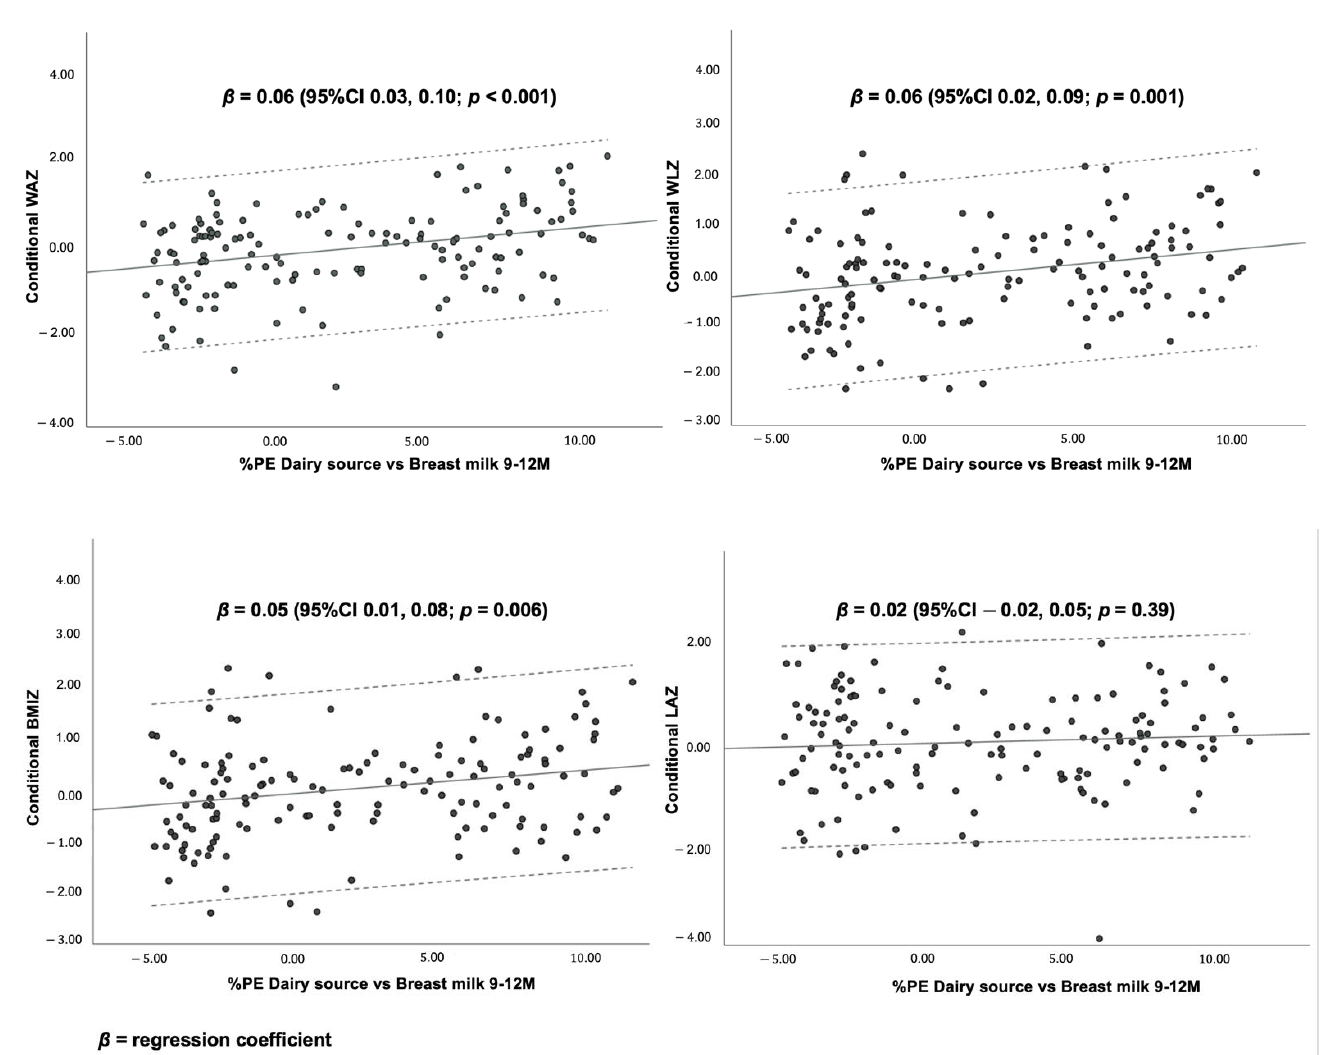
Figure 4. Scatter plots and linear regression statistics for conditional growth outcomes by %PE from dairy source vs. breast milk at 9 – 12 months.